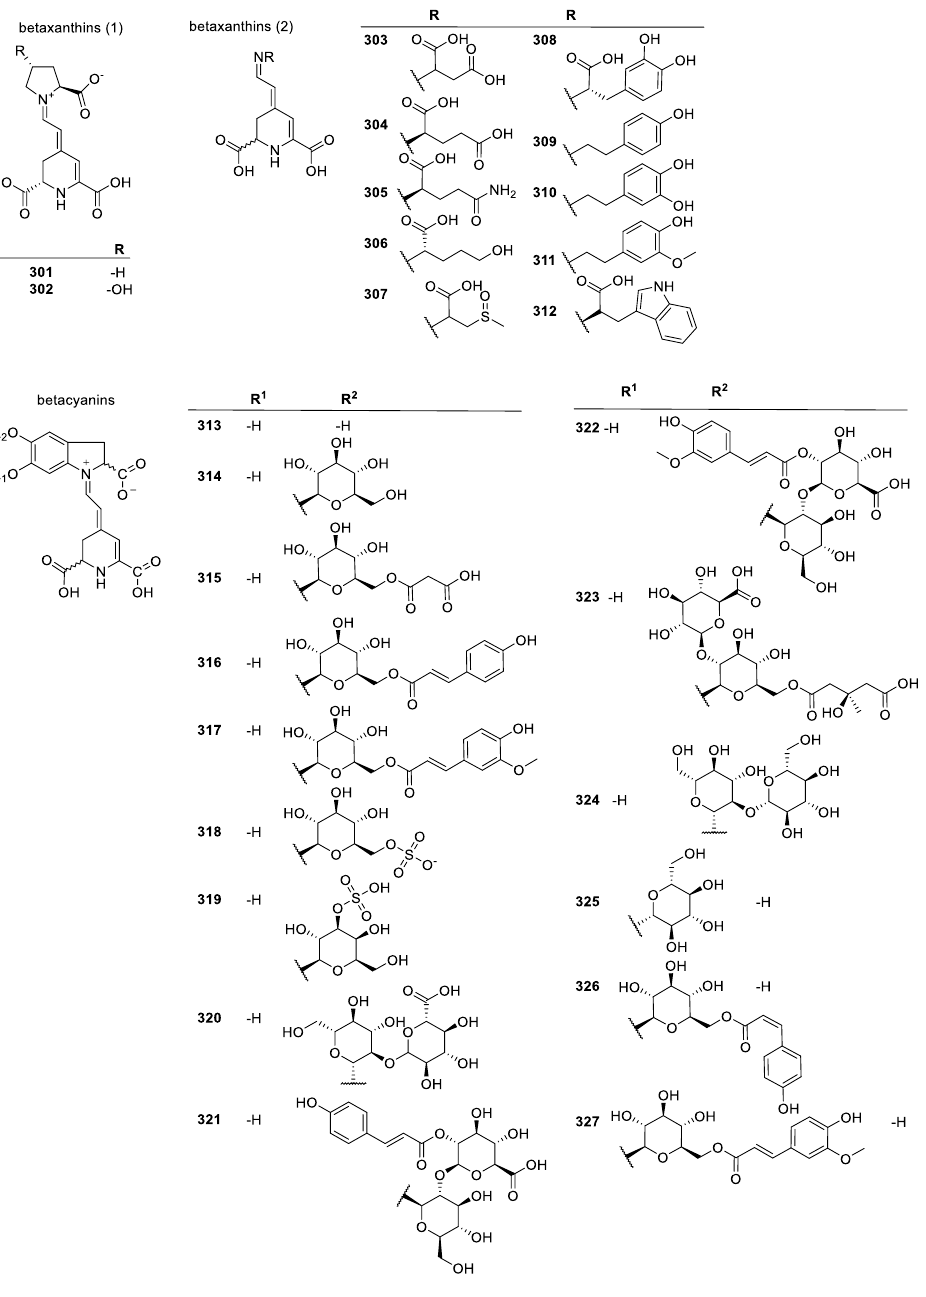
Figure 20. Structures of betaxanthins and